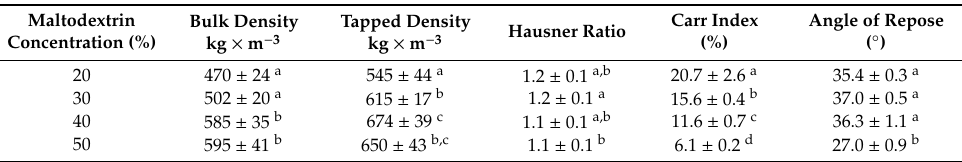
Figure 3. FTIR spectra of Andean blueberry juice ( a ); maltodextrin ( b ); and Andean blueberry juice powders with maltodextrin at 20% ( c ), 30% ( d ), 40% ( e ), and 50% ( f ).